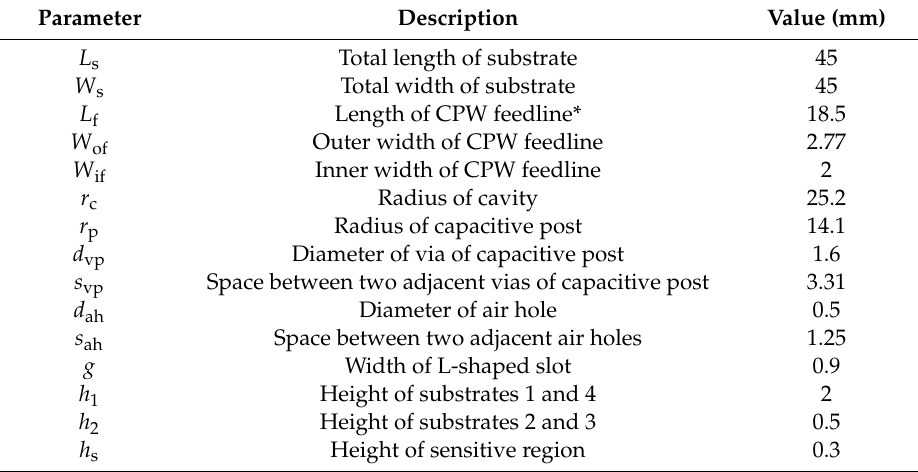
Table 1. Geometrical parameters of the final optimized